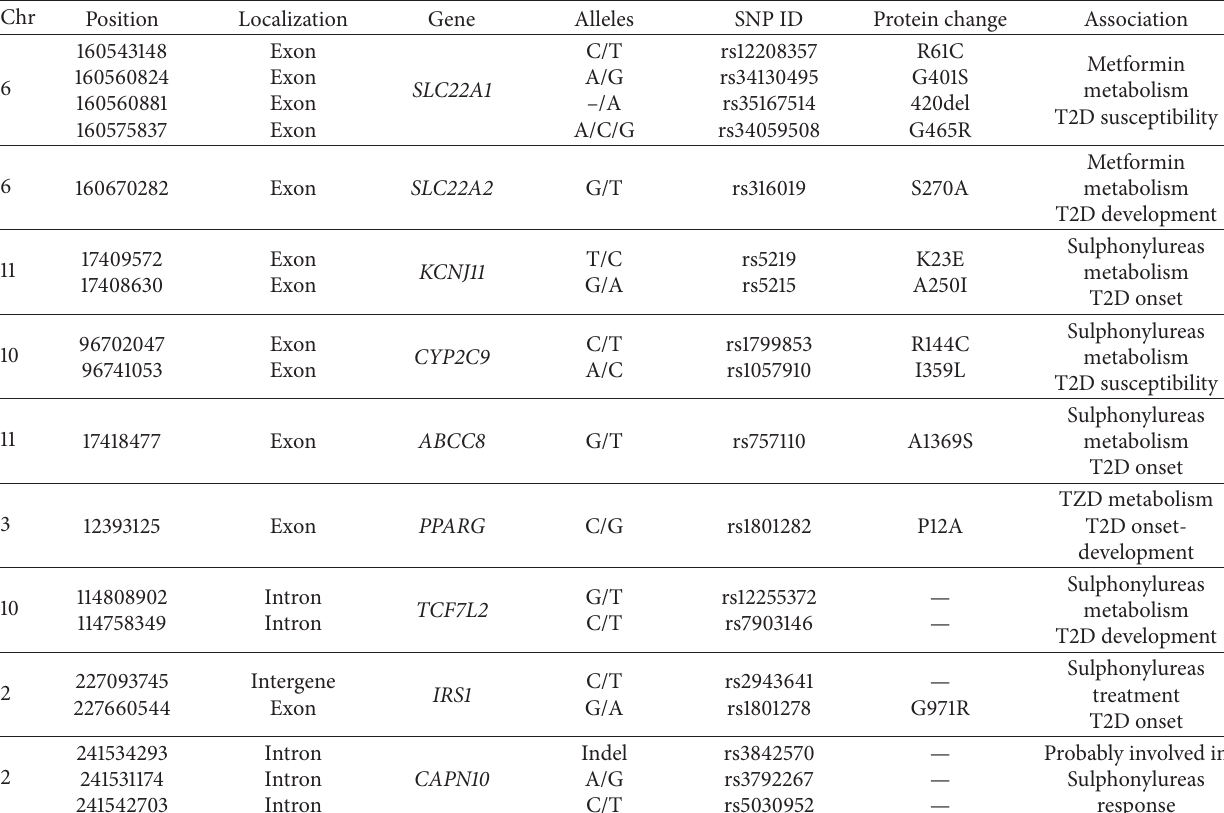
Table 1: Schematic catalogue of SNPs commonly associated with